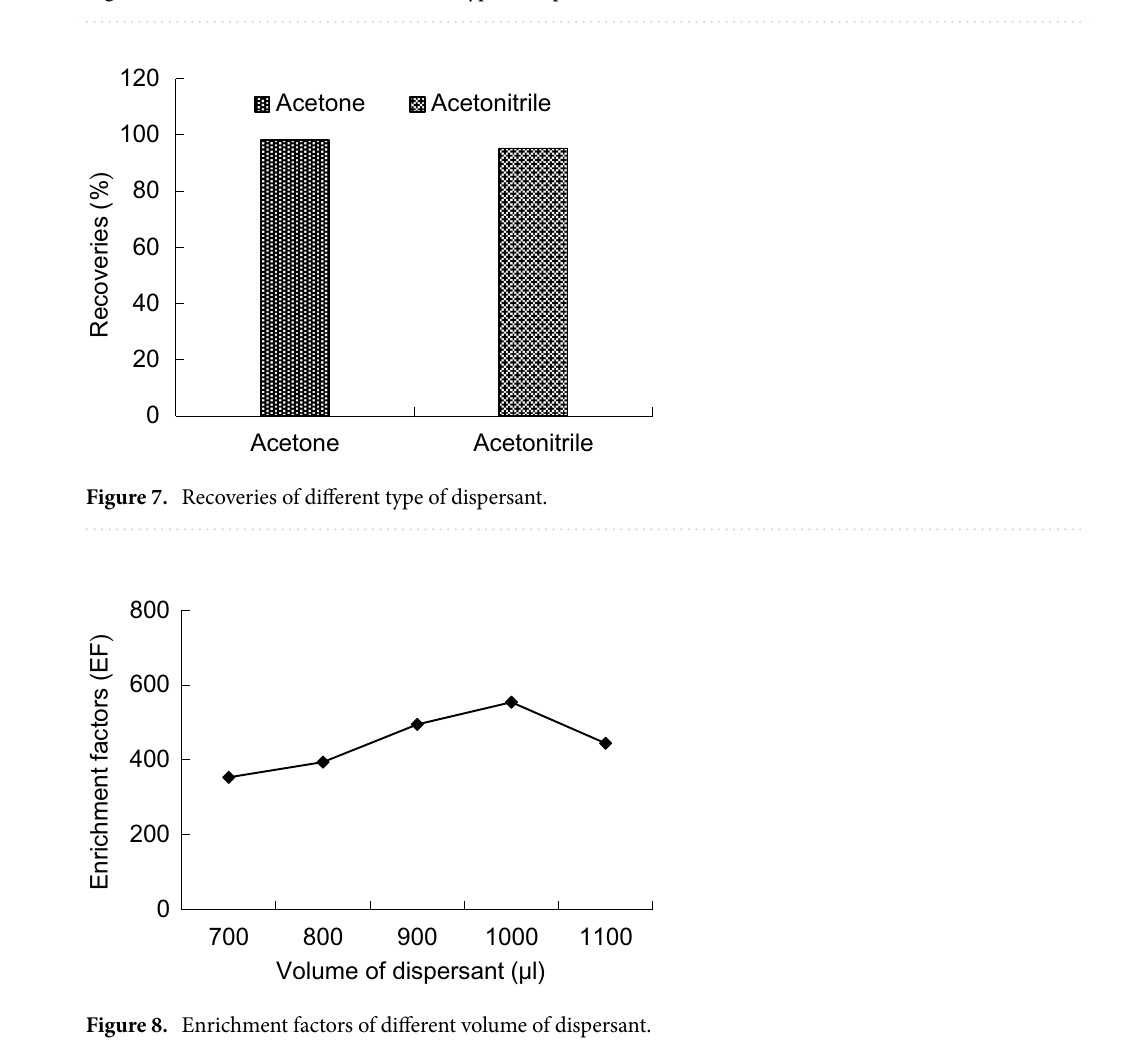
ditions, the peak area of chlorpyrifos had good linear relationship within a certain range, the Regression equa- tion was Y = 16086x − 1448, the regression coefficients were greater than 0.999. The LOD was 0.02 μg/mL. The enrichment factor was 554.51. The recoveries for standard addition was 98.07%, the intra-day relative standard deviations (RSD, n = 4) was 4.61%, the veracity and accuracy of the method can meet the requirement of pesti- cide residue analysis (Table 1).